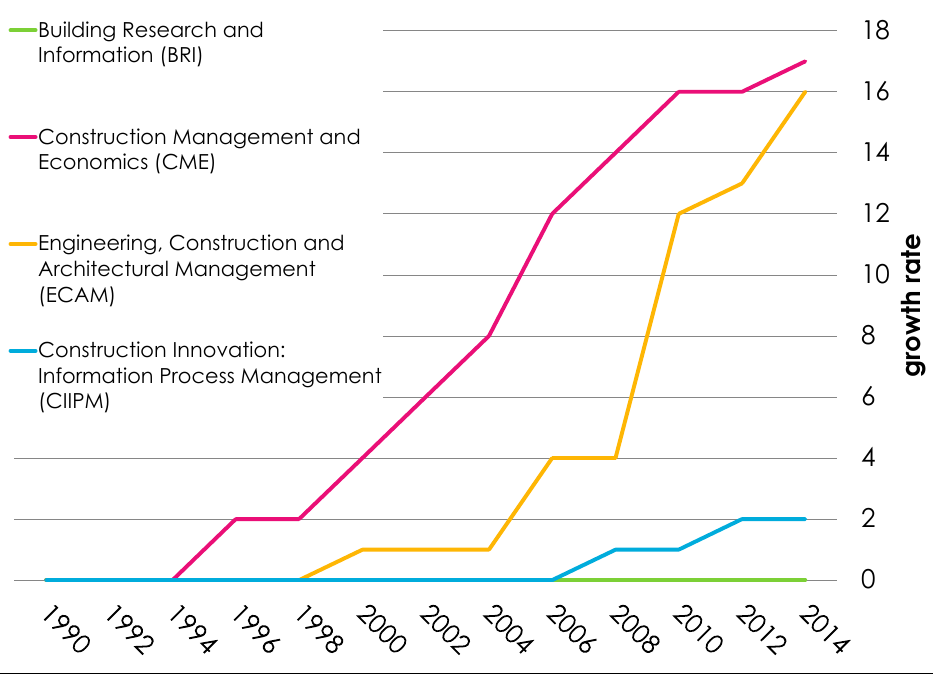
Figure 2 Growth rate of maturity-related publications in selected